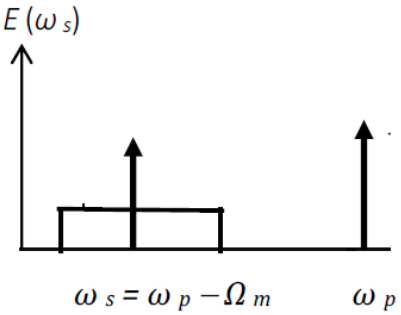
Figure 2. Electro-optic parametric amplification filtering out a narrow band of the signal spectrum through frequency downshifting of pump photons ( ω p ) by a modulating frequency Ω m .